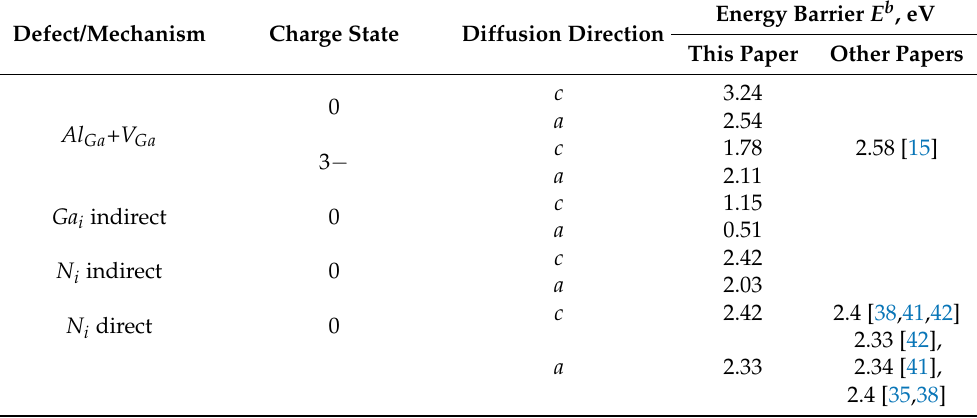
Table 3. Heights of the migration energy barriers in bulk wz-GaN. A positive charge state of the vacancy represents p -type dopant, while a negative one, n -type dopant. Explanation of